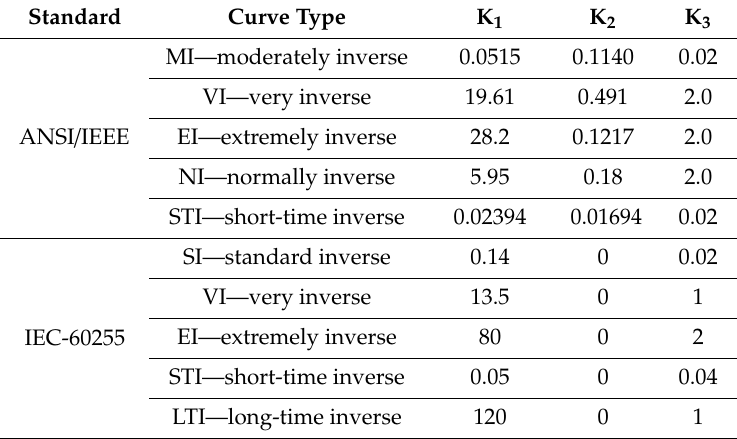
Table 2. Standard curve parameters for inverse time overcurrent